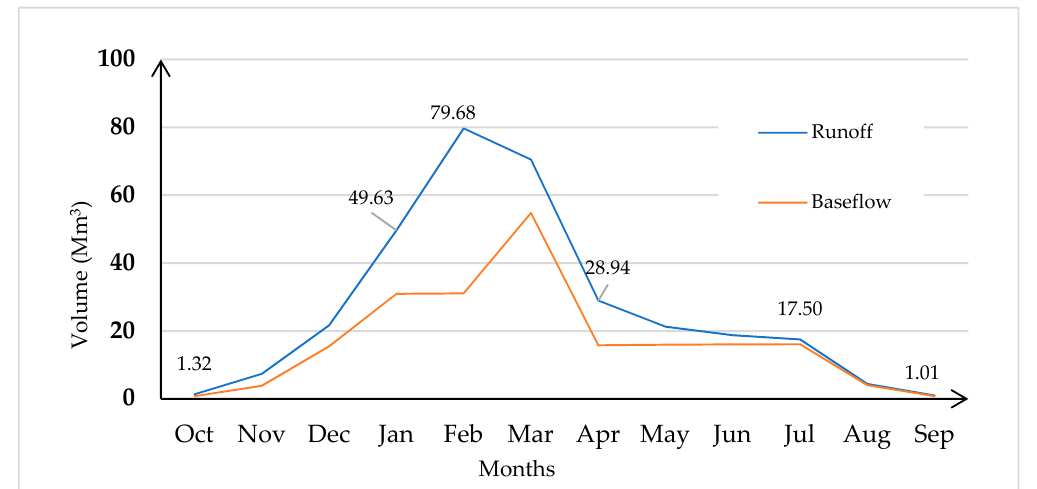
Figure 8. Monthly runoff and baseflow in Chongwe River Catchment .